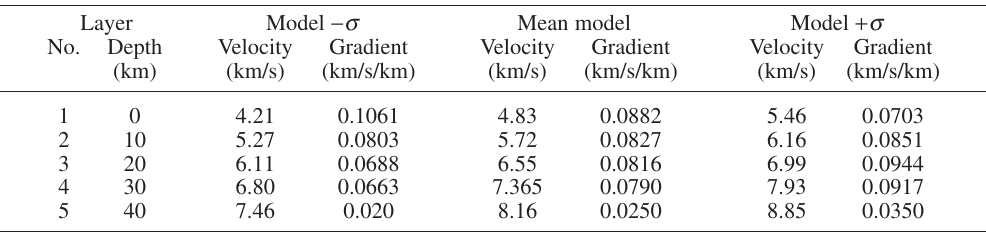
Table II. Mean 1D model